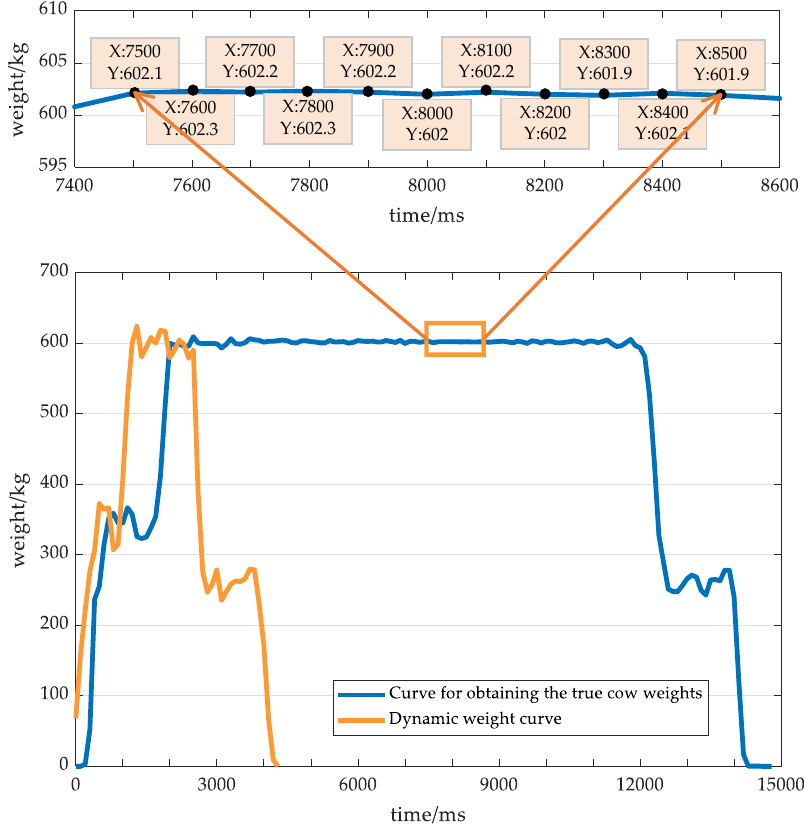
Figure 9. Curve for obtaining the true cow